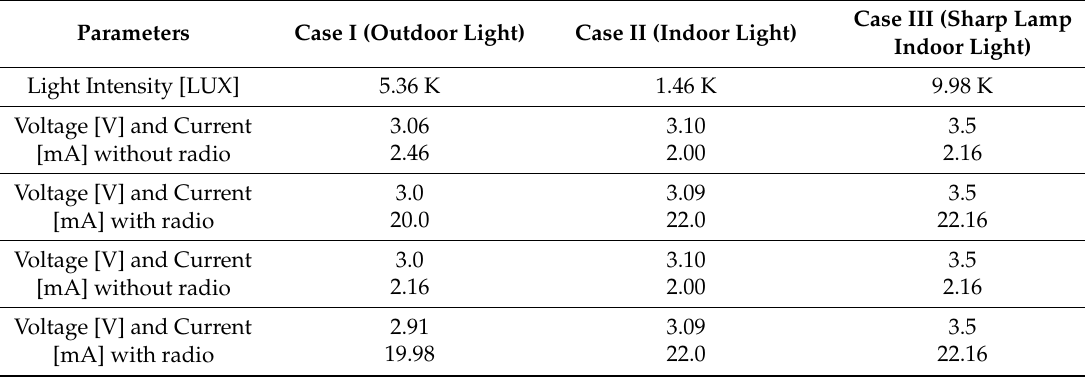
Table 3. First and second rows: measured voltage and current for the MSP ‐ EXP430FR5739+CC2500 used as a transmitter. Third and fourth rows: measured voltage and current for the MSP ‐